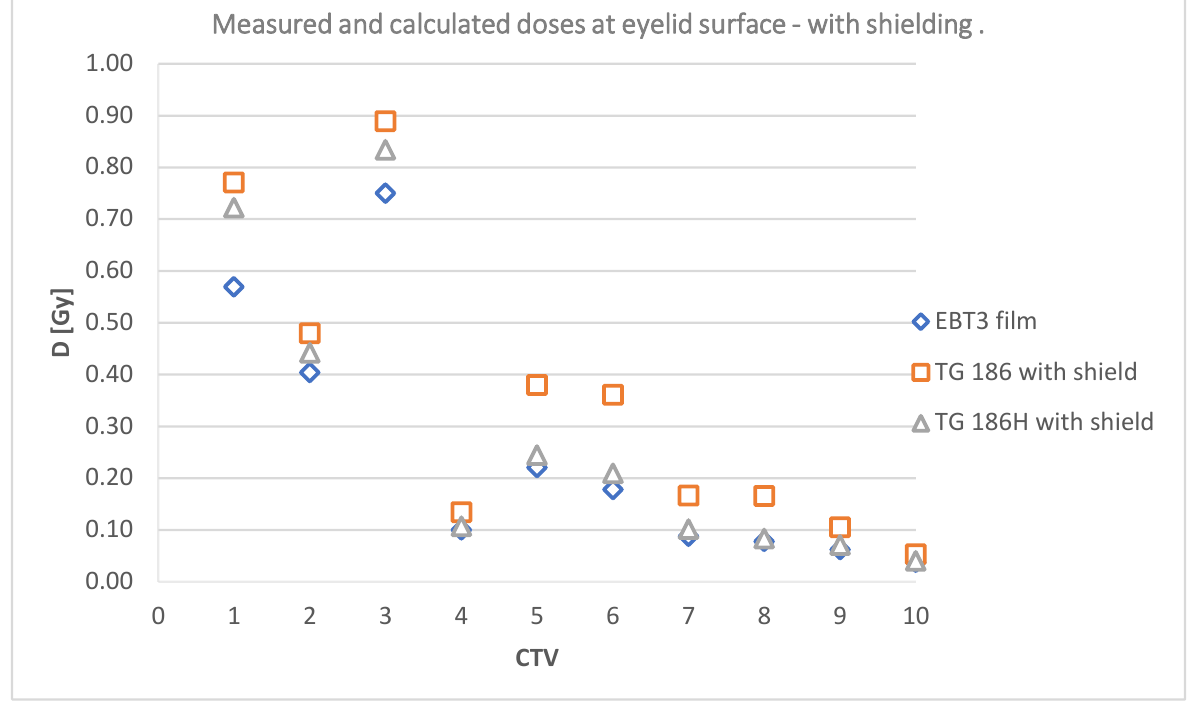
Figure 13. Deposited doses measured at a point on the surface of the eyelid using the lead shielding.